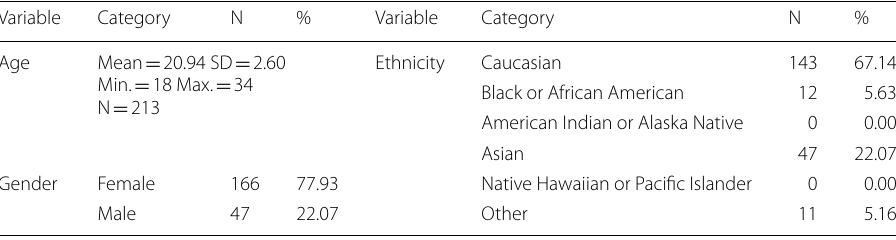
Table 2 Descriptive analysis of demographic information (n